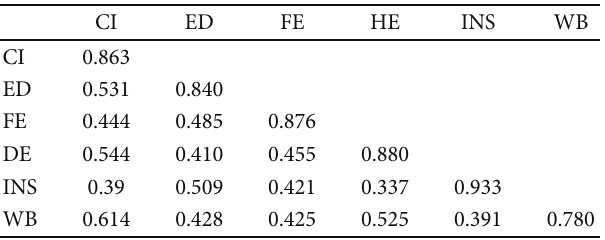
Table 3: Discriminant validity of the construct